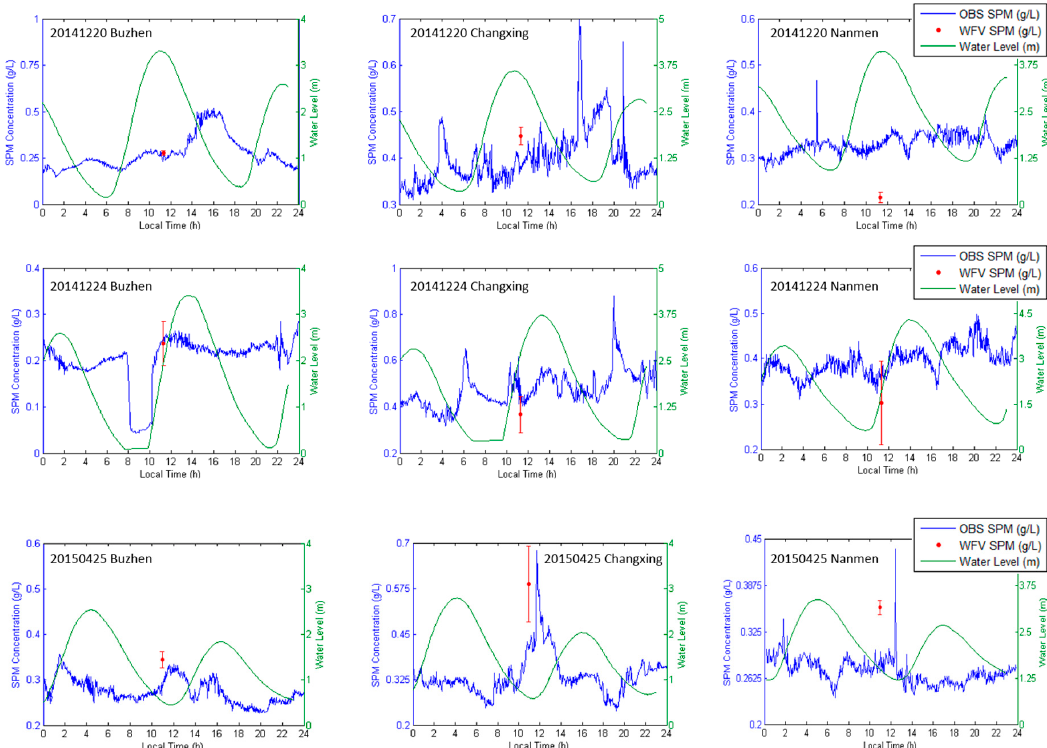
Figure 11. Comparison between WFV derived SPM and fixed-station OBS observed SPM at three fixed station (Nanmen, Changxing and Buzhen) on three days (20 December 2014, 24 December 2014 and 25 April 2015). Red point is the average of WFV derived SPM concentrations of pixels within a 3 × 3 box centered at the station’s location, and the error bar indicated the standard deviation (STD). Green line and blue line is the OBS observed water level and SPM concentration respectively.